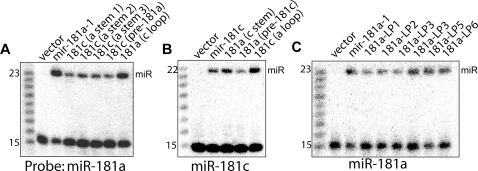
Mature miRNAs produced from the mir-181a-1/c mutants have the same 5′ ends.The 5′ ends of mature miR-181a (A) and miR-181c (B) produced from mir-181a-1/c domain swapping mutant genes, and the 5′ ends of mature miR-181a (C) produced from mir-181a-1 loop mutant genes were determined by primer extension analyses. Synthetic miR-181a or miR-181c oligo nucleotides in single nucleotide increments (15 nt–22/23-nt) were radio-labeled and used as size ladders. The upper band represents the major cDNA product of miR-181a (23-nt) or miR-181c (22-nt), and the lower band represents radio-labeled probes for the mature miRNAs.